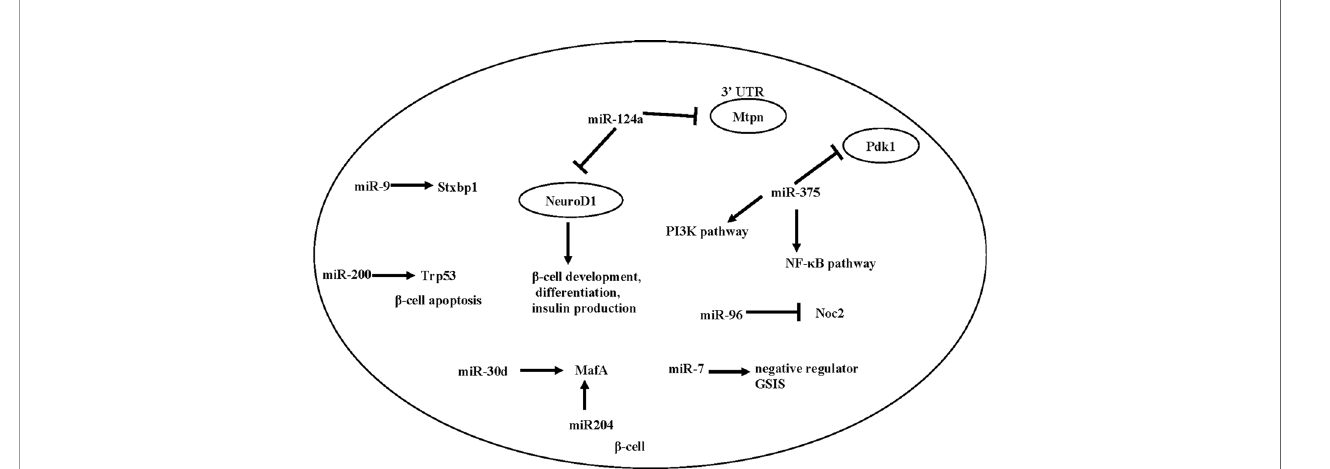
FIGURE 1 | miRNAs involved in insulin release in pancreatic beta cells and beta cell